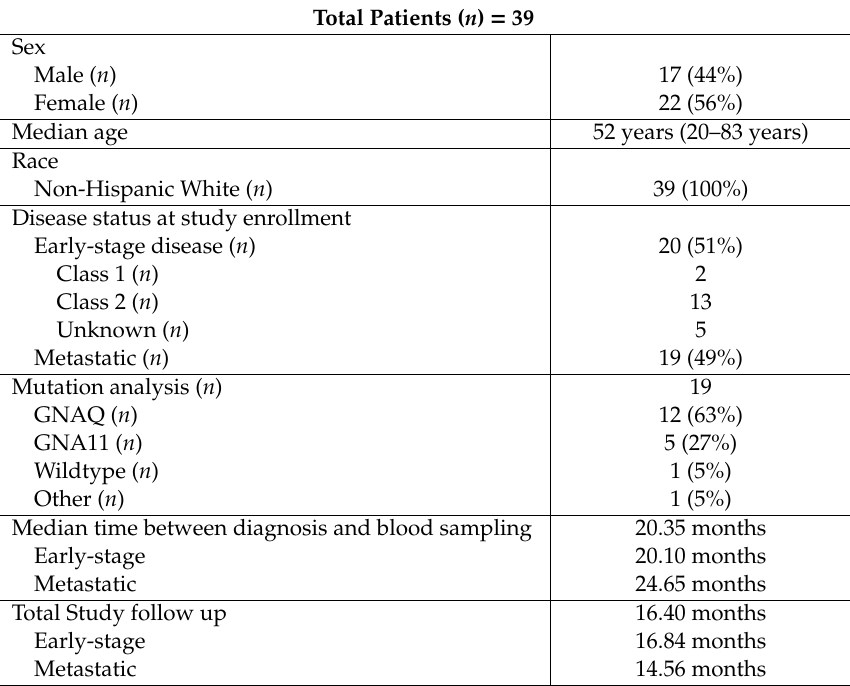
Table 1. Patient